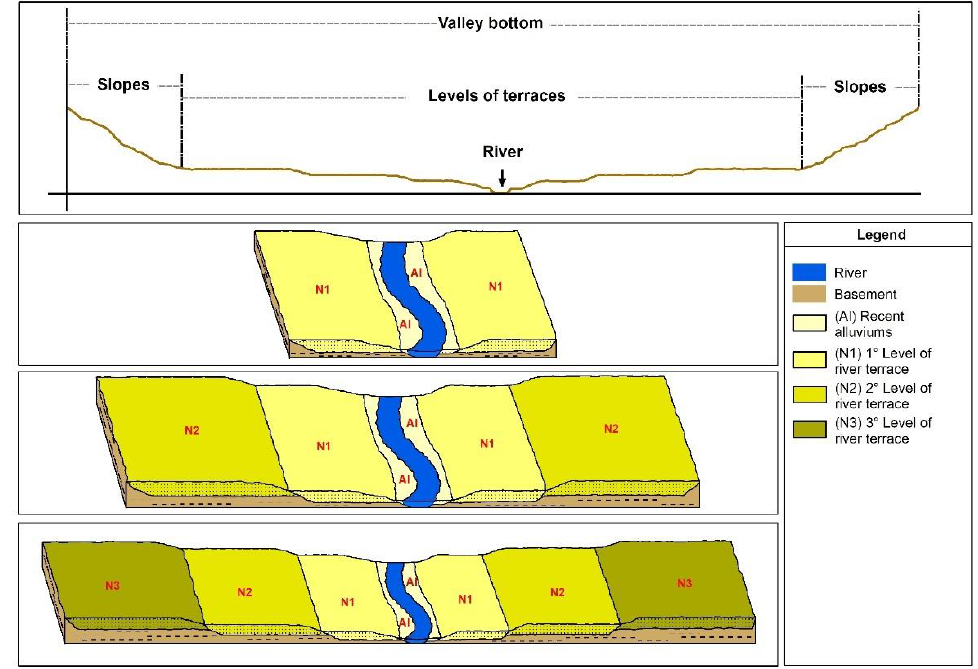
Figure 3. Schematic model of the distribution of low river terraces considered in the present study.